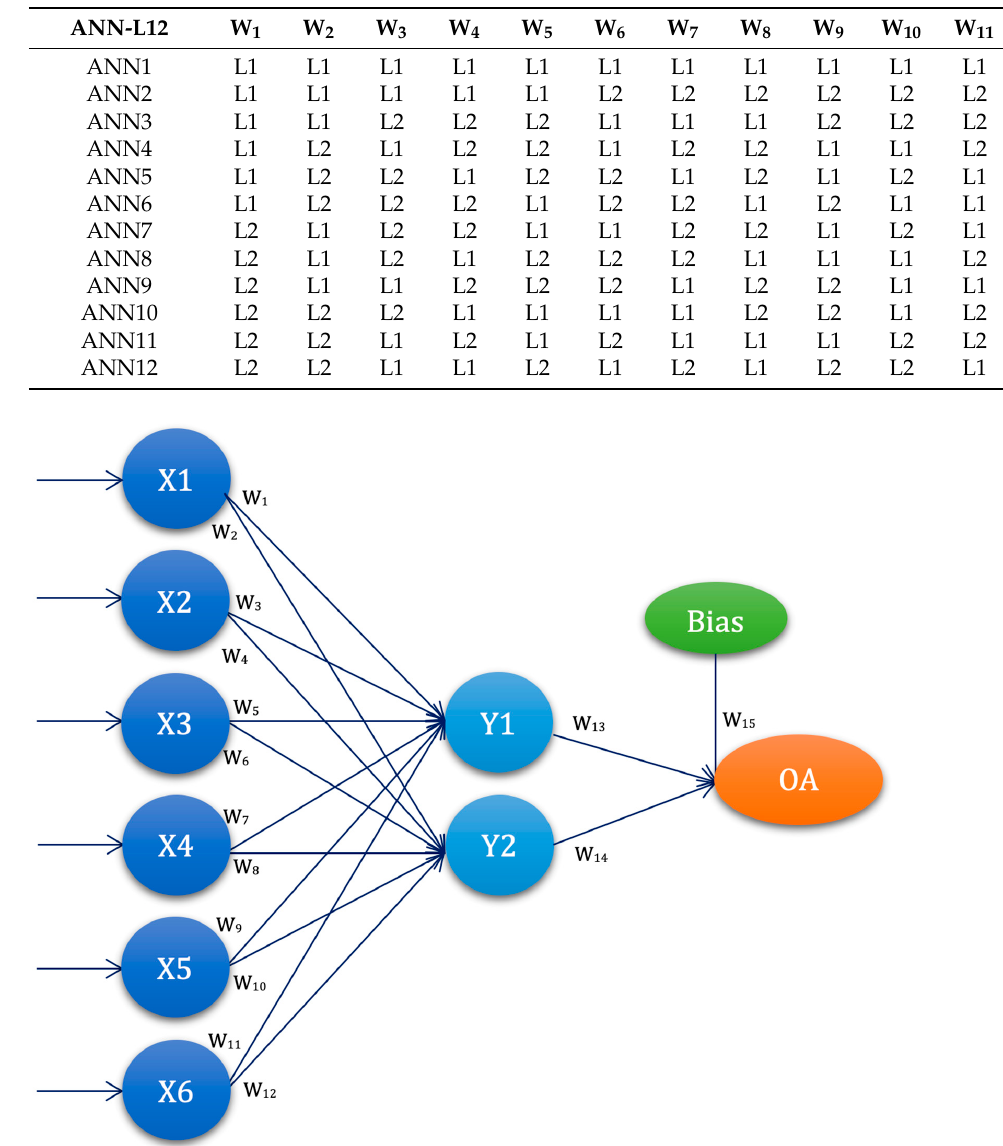
Figure 3. ANN-L16 architecture—graphical representation.